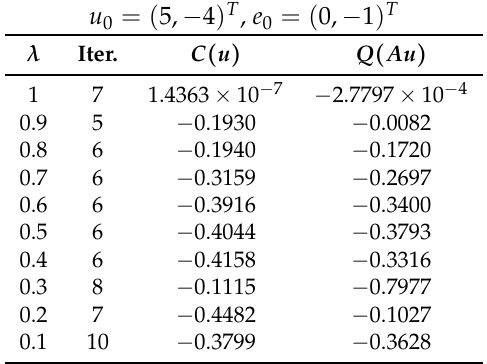
Table 1. Numerical results for solving Example 1 with different λ .